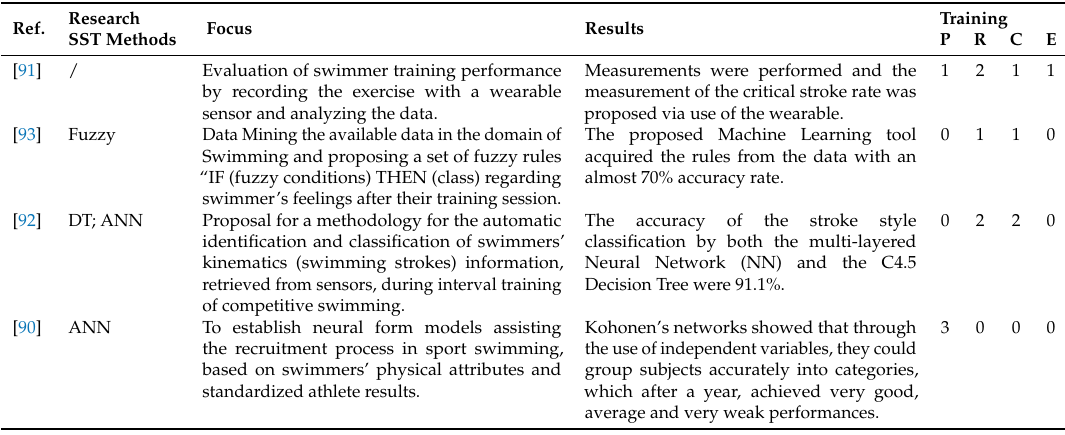
Table 12. Identified studies in the domain of swimming.